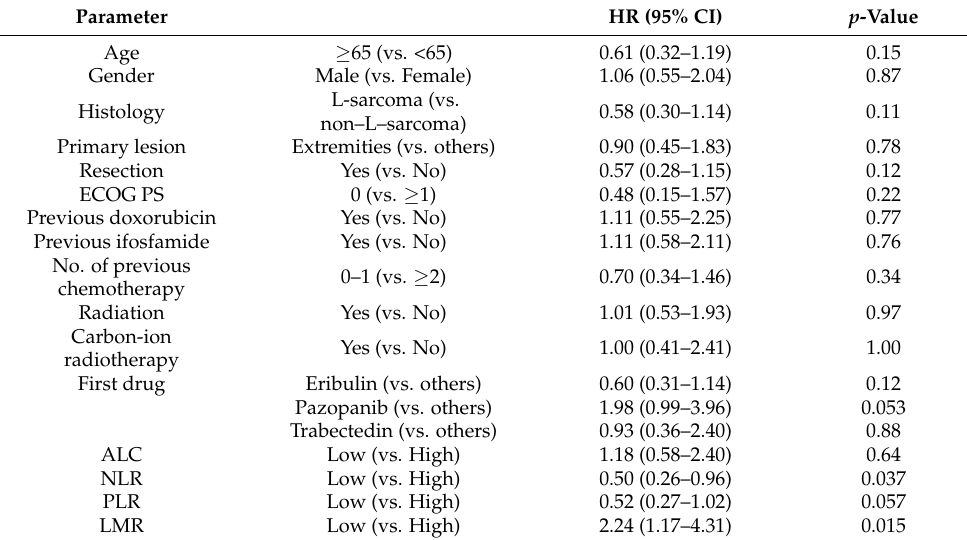
HR, hazard ratio. 95%CI, 95% confidence interval. ECOG PS, Eastern Cooperative Oncology Group performance status. ALC, absolute lymphocyte count. NLR, neutrophil-to-lymphocyte ratio. PLR, platelet-to-lymphocyte ratio. LMR, lymphocyte-to-monocyte